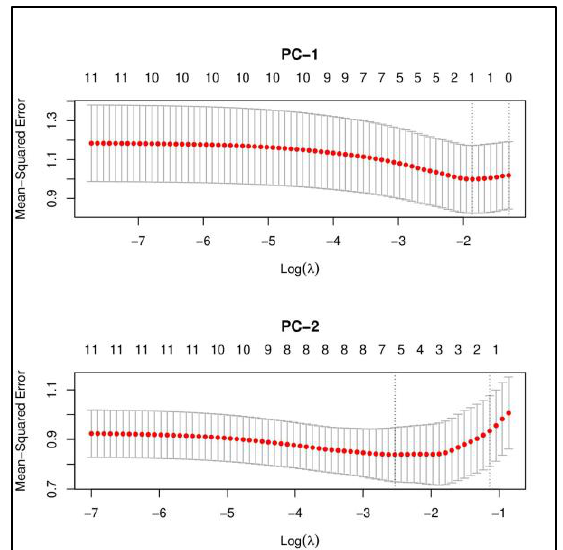
Figure 8. Cross-validated lasso regression plots for (top) PC-1 and (bottom) PC-2 as the independent variables. The x-axis is the log of the shrinkage penalty, and the y-axis is the cross-validated mean squared error. The numbers at the top of the plot indicate the number of variables with non-zero coefficients at that shrinkage parameter. The dotted line denotes the cross-validated value with the lowest mean-squared error.